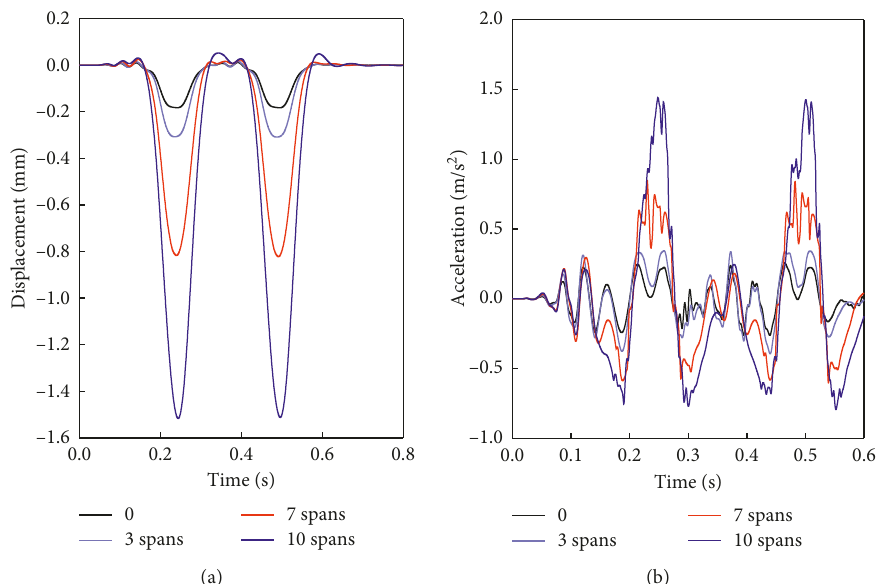
Figure 12: Dynamic displacement and acceleration of the concrete base with different lengths of contact loss zone: (a) dynamic dis- placement and (b) acceleration.